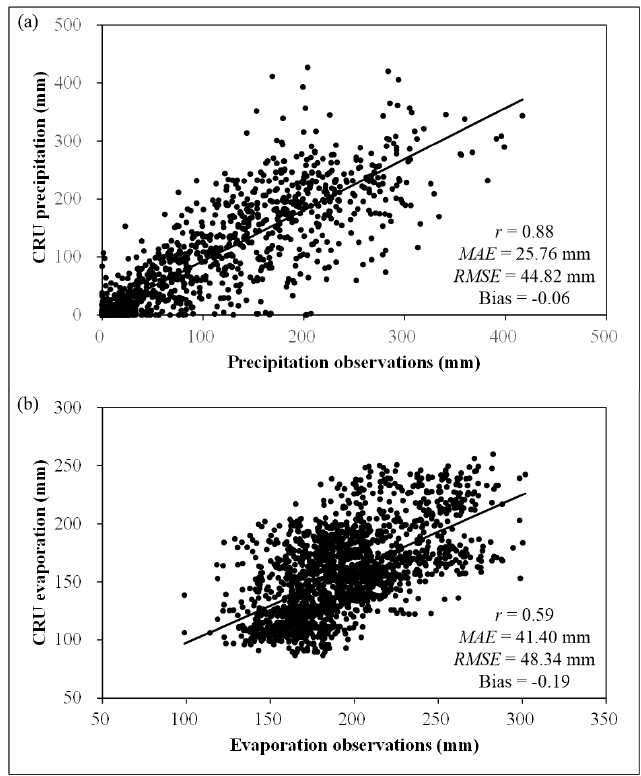
Figure 23. Scatterplots of precipitation and evaporation observations versus those retrieved from CRU product.